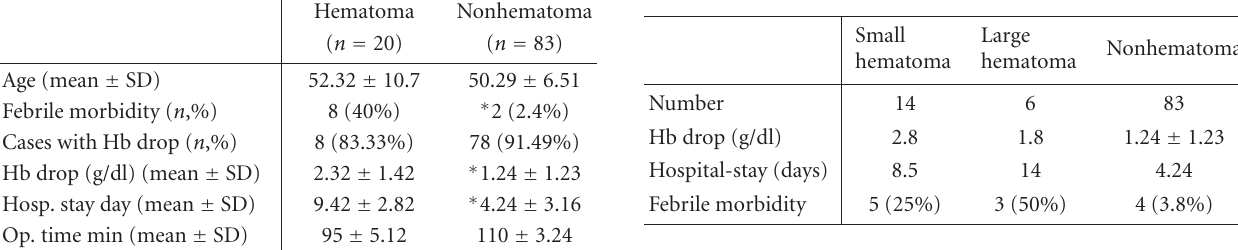
Table 1: Summary of results. Table 2: Relation between postoperative morbidity and size of